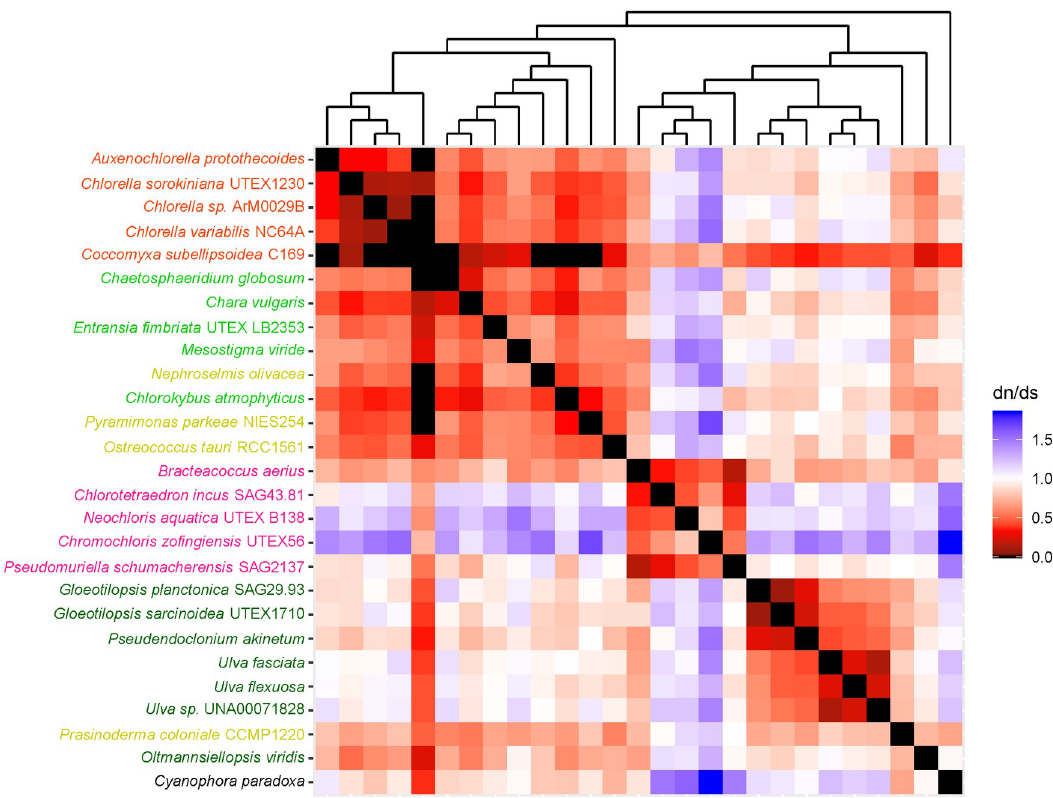
Fig 3. Heatmap of pairwise dN/dSdn/ds ratios calculated from alignment of mitochondrial nad 2. The scale bar represents color corresponded to pairwise dN/dS ratios. The cladogram above the heatmap corresponds to phylogenetic relationship estimated using algal nad